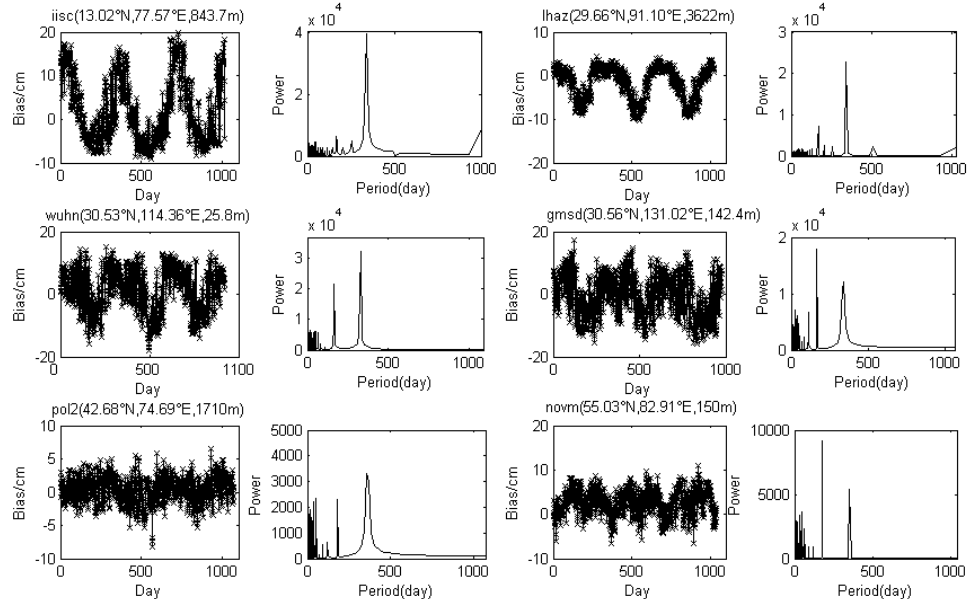
Figure 2. Variation of the daily bias and spectral analysis based on Fourier transformation at IISC, LHAZ, WUHN, GMSD, POL2 and NOVM sites in 2008–2010. The latitude, longitude, and altitude of each site are listed in the brackets.